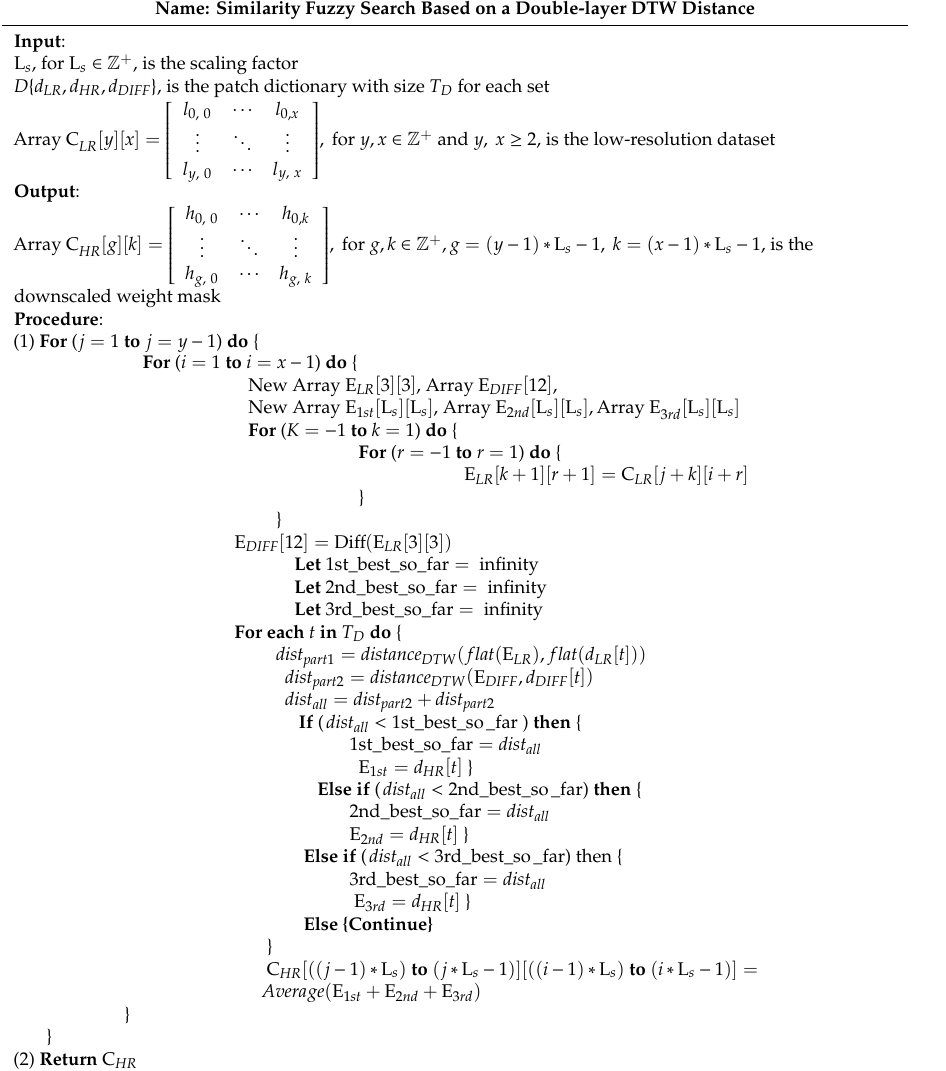
Table 4. A double-layer Dynamic Time Warping (DTW) similarity fuzzy search